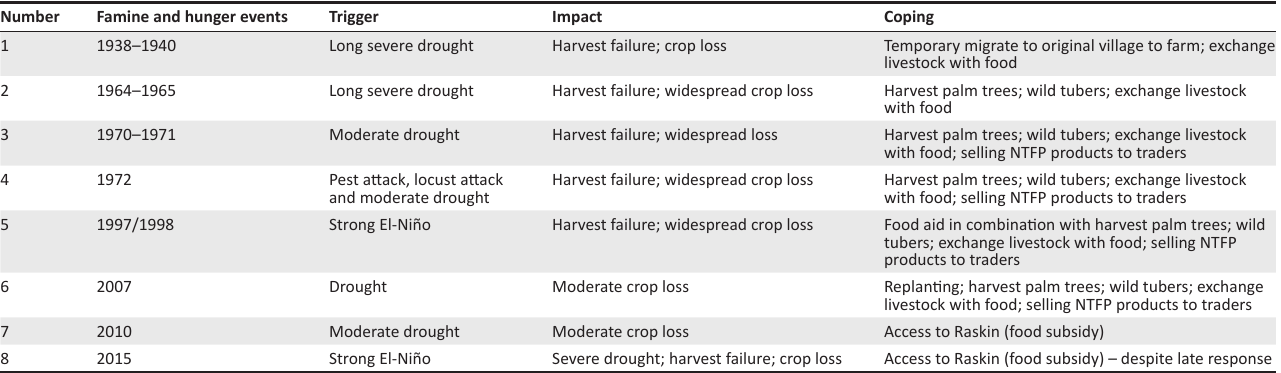
TABLE 4: Drought-related hunger and famine history in Toineke.